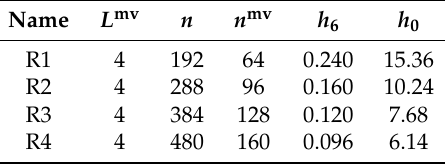
Table 2. Grid configurations employed in the simulations for the different resolutions. The columns refer to the simulation’s name, the number of moving boxes L mv , the number of grid points per direction in the static levels n , the number of grid points per direction in the moving levels n mv , the grid spacing in the innermost level h 6 (corresponding to l = 6) and the grid spacing of the coarsest level h 0